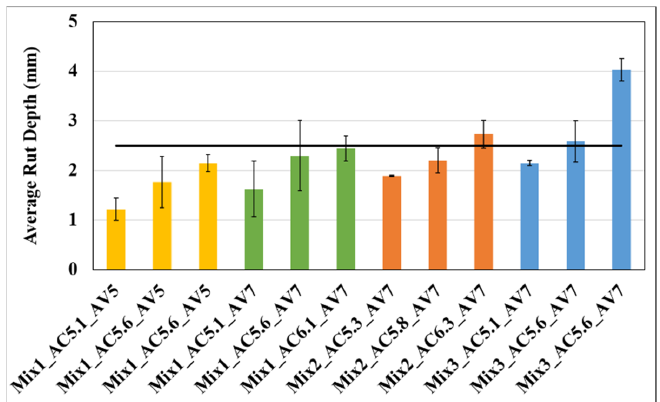
Figure 3. HWTT test results for all mixtures at 50 °C (length of the error bar is equal to one standard deviation). The number after AC indicates the percent asphalt (or binder) content and the number after AV represents the percent air voids of the samples.